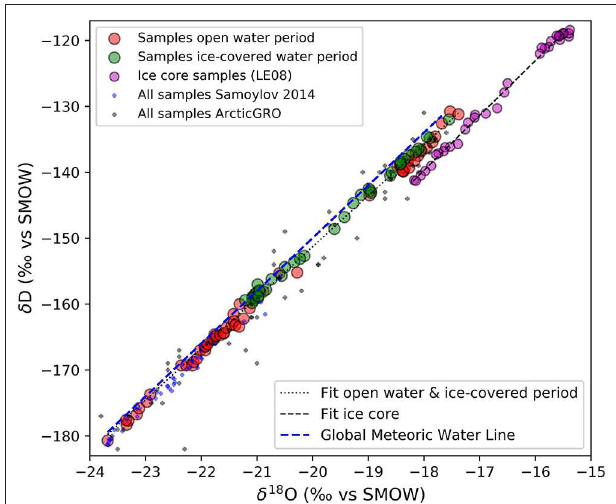
FIGURE 4 | Relationship between δ 18 O and δ D for open water (red) and ice-covered (green) samples. The black dotted line shows the linear regression of samples from open water period (28 May 2018 to 22 October 2018) and ice-covered period (until 27 May 2018 and from 23 October 2018) combined ( δ D = 7.73 × δ 18 O + 3.36). The black dashed line shows the linear regression of ice core samples ( δ D = 8.33 × δ 18 O + 10.14). The blue dashed line shows the global meteoric water line after Craig (1961). Additional samples from Samoylov 2014 (blue crosses) and ArcticGRO (gray crosses) include samples from the ice-covered period as well as open water